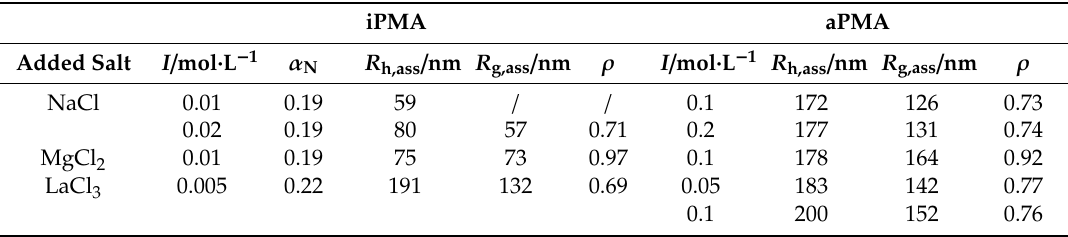
Table 3. Hydrodynamic radii ( R h,ass ), radii of gyration ( R g,ass ) and parameter ρ ( = R g,ass / R h,ass ) for associates of iPMA ( α N ≈ 0.2; see third column) and aPMA ( α N = 0) in the presence of NaCl, MgCl